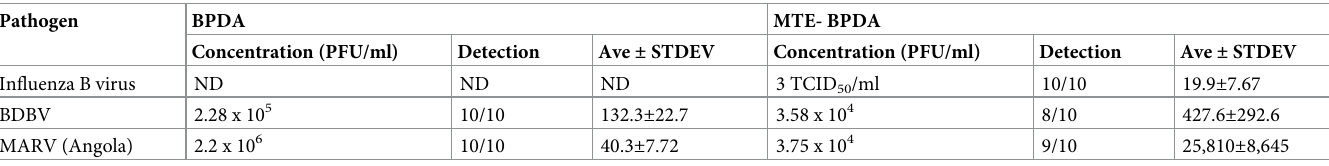
Table 2. Confirmation of